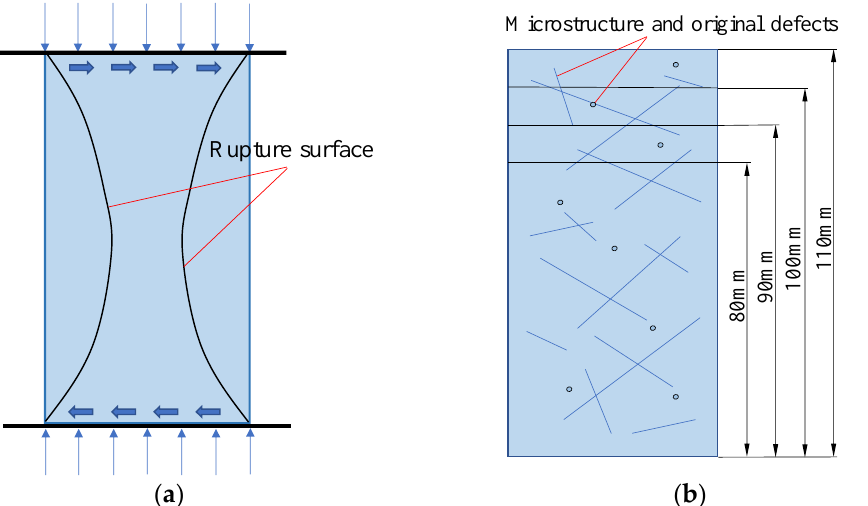
Figure 3. Influencing factors of rock size effect. ( a ) End-face friction effect ( b ) Distribution of primary defects in rock.